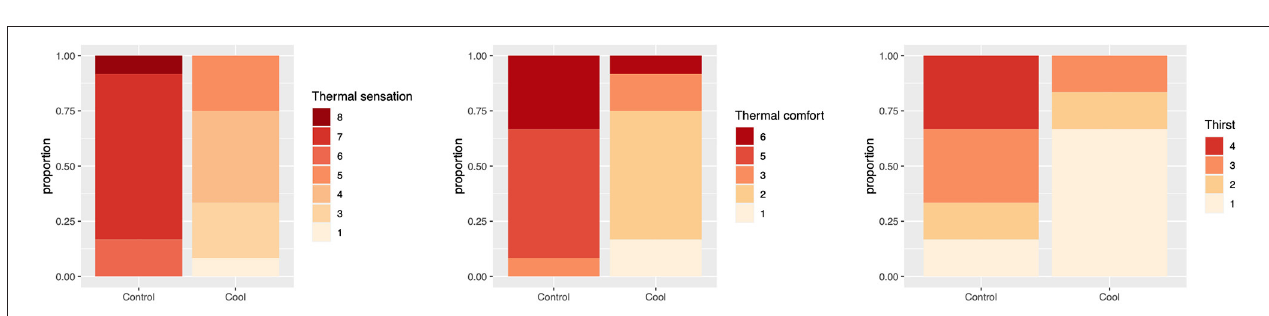
FIGURE 3 | Thermal sensation, comfort and thirst by Control and Cool.